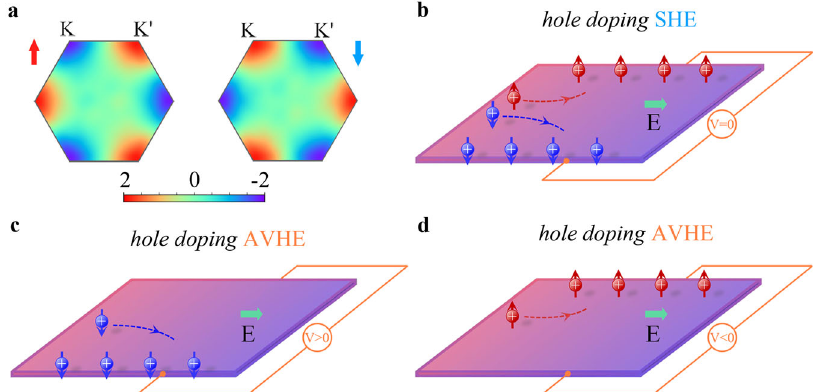
Fig. 3 Berry curvatures and AVH effect. a Berry curvatures of the spin-up and spin-down channels over the 2D Brillouin zone for monolayer MnPSe 3 . b Diagram of the spin and valley Hall effects in monolayer MnPSe 3 under hole doping in presence of an in-plane electric fi eld. Diagrams of the spin Hall and AVH effects in c h-I ↓ and d h-II ↓ con fi gurations under hole doping in presence of an in-plane electric fi eld. Red/ blue arrows in b – d indicate spin-up/down states, and the “ + ” / “ − ” symbols indicate holes/electrons from the K ′ valley.